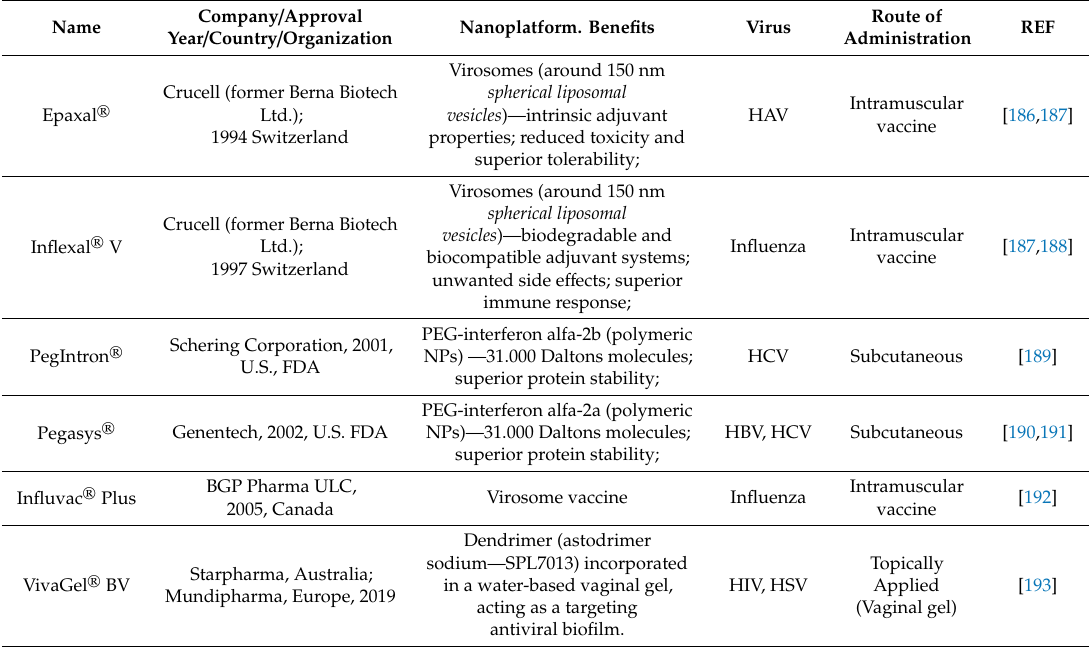
Table 3. ExamplesofapprovednanoplatformsfordrugdeliverybytheFDA,EMAandotherorganizations (updated table, after Singh et al.